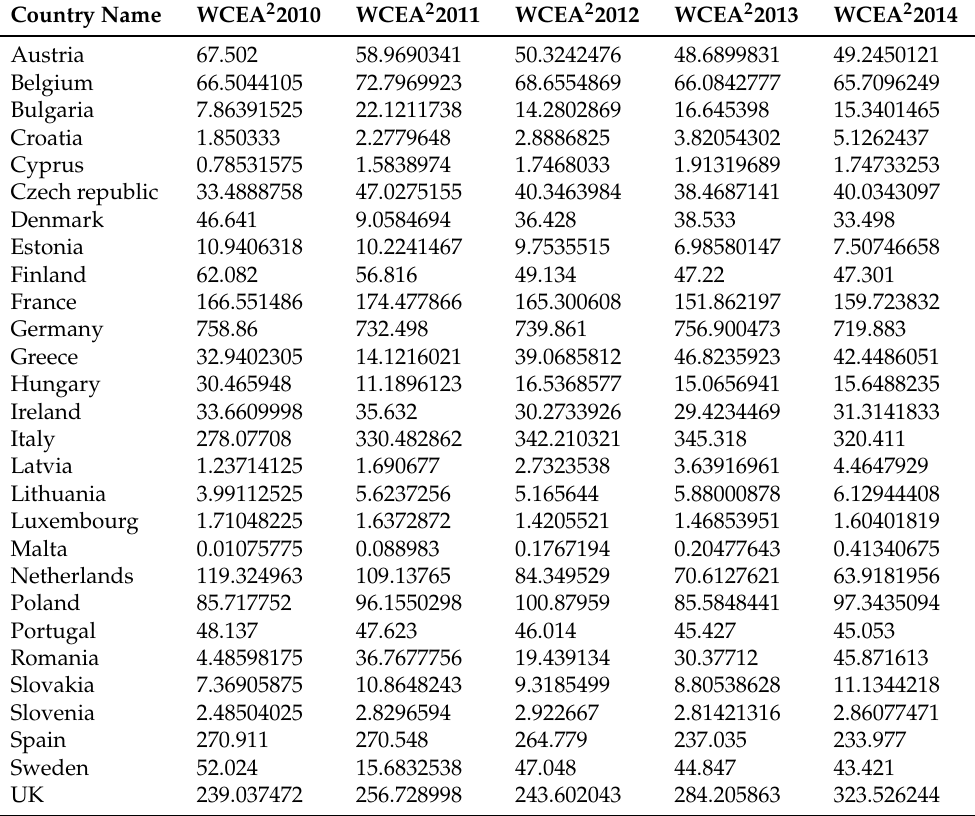
Table A4. Allocation vectors provided by the WCEA solution with renewable energy production as a unique weight (denoted by WCEA 2 ) for each year in the interval 2010–2014 (values are in millions of tons of CO 2 ).